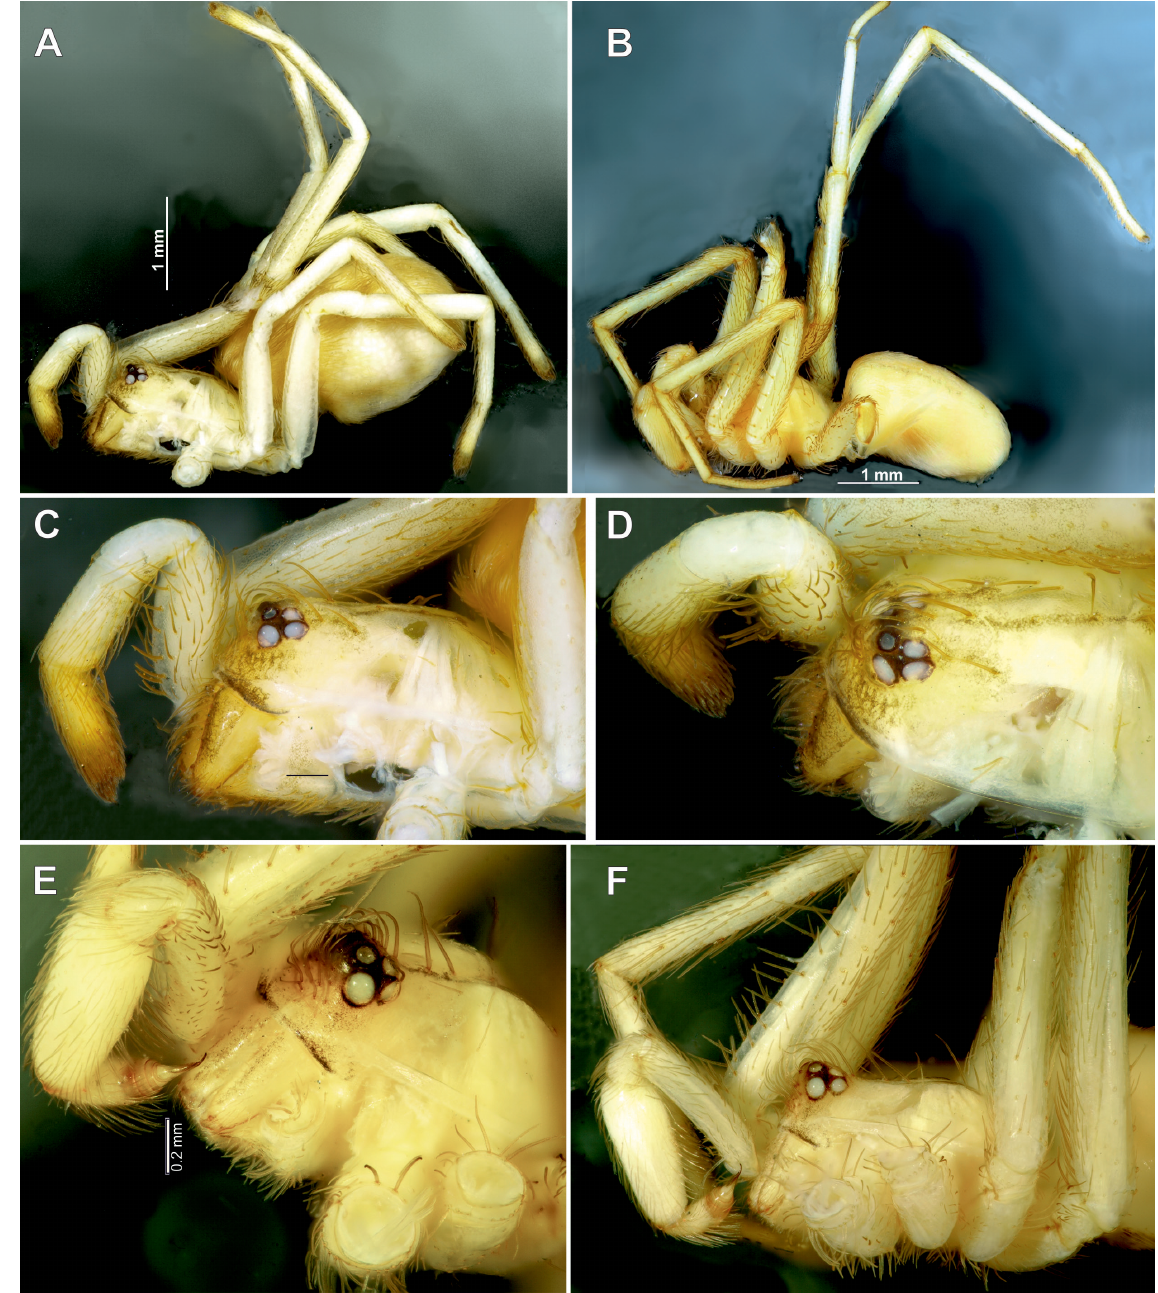
Fig. 34. Somatic characters of Zaitunia ferghanensis sp. nov., paratype, ♀ from Kurshab ( A , C–D ) and paratype, ♂ from Osh ( B , E–F ). — A–B . Habitus, lateral. C , F . Prosoma, lateral. D . Same, dorso-lateral. E . Same,